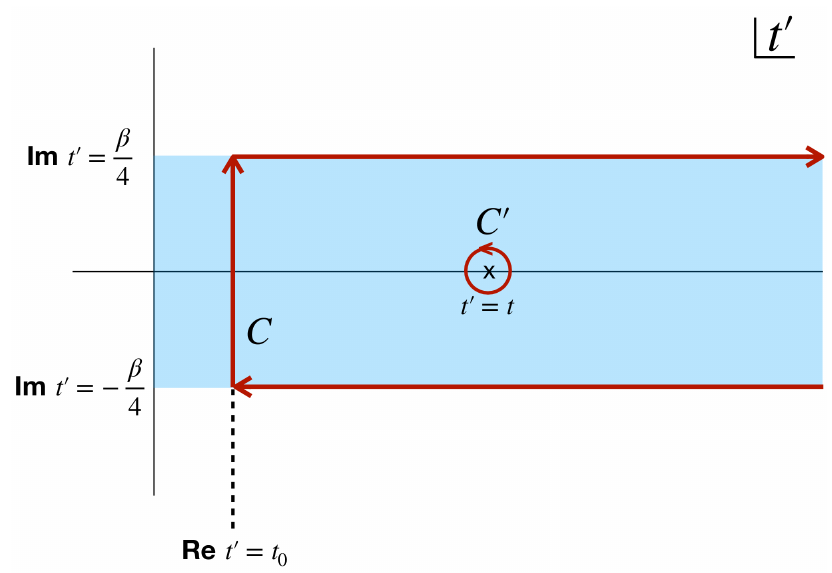
Figure 2 . The OTOC F ( t ) , as defined in (1.1), is analytic in the shaded blue region. Contours for deriving the dispersion relation (2.12), where t is the factorization time, are shown in red. The 0 contour C 0 surrounds a simple pole at t 0 = t of the integral